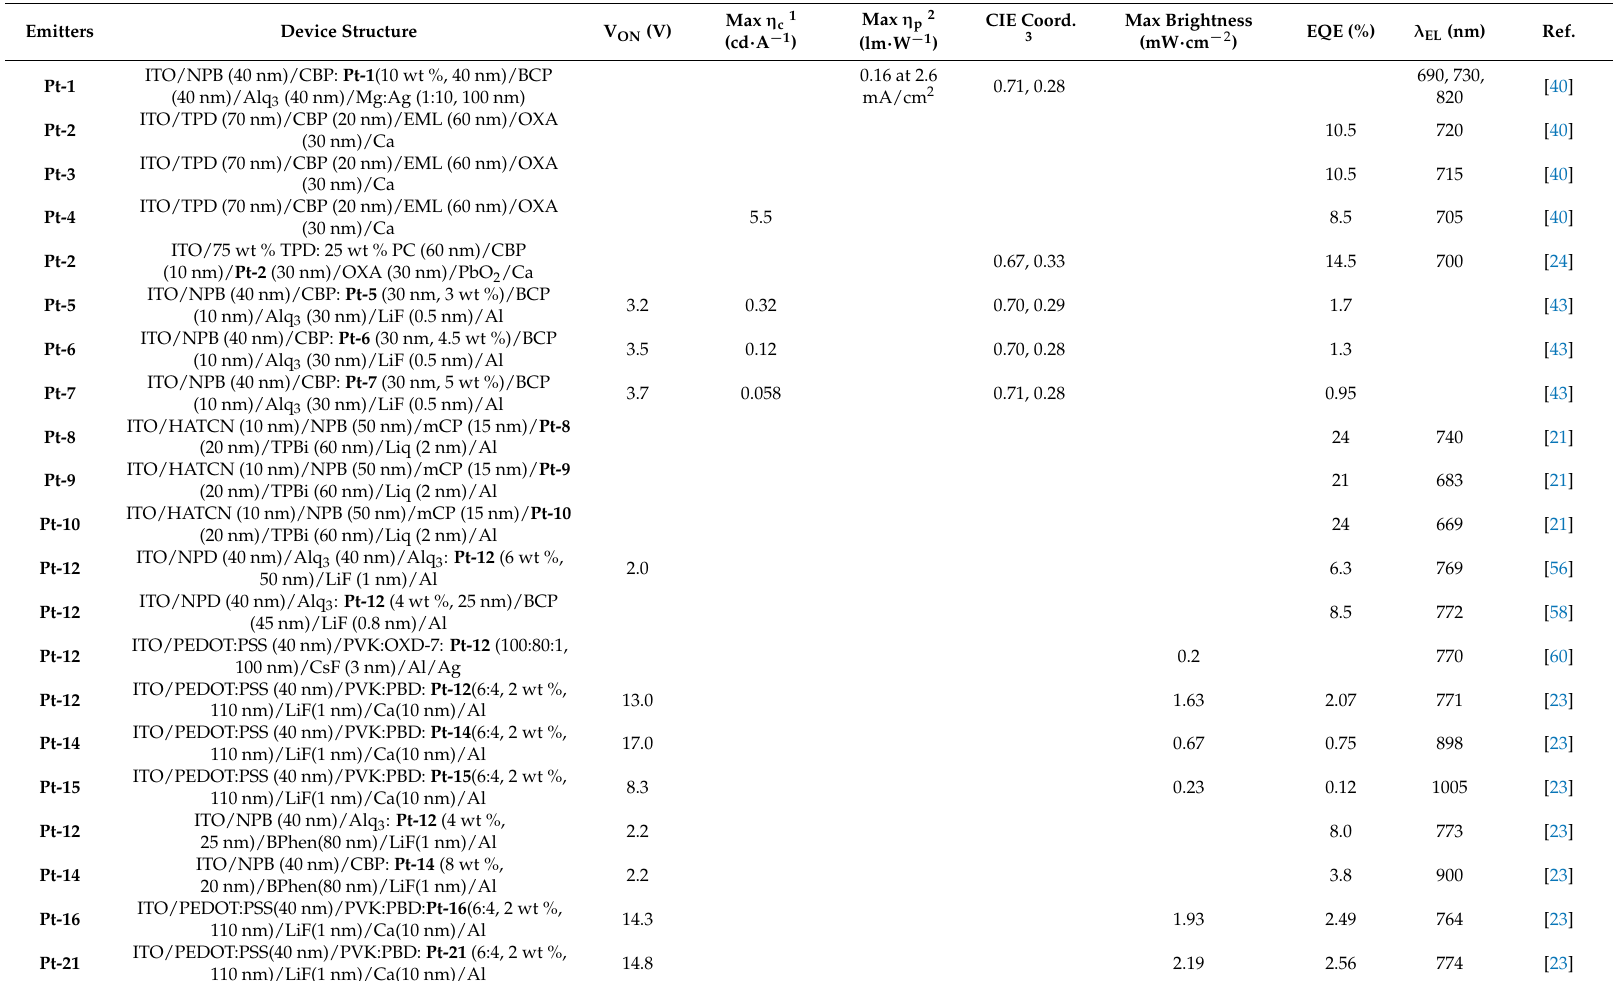
Table 1. Summary of electroluminescent properties of organic light-emitting diodes (OLEDs) fabricated with